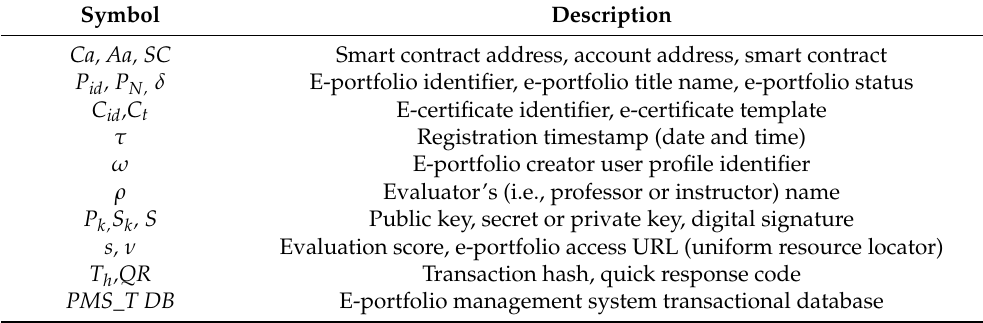
Table 3. Notation